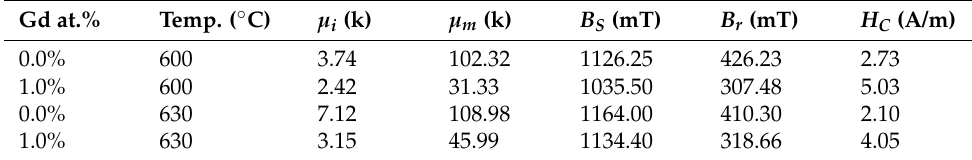
Table 8. Static soft magnetic performances after tension annealing. Gd